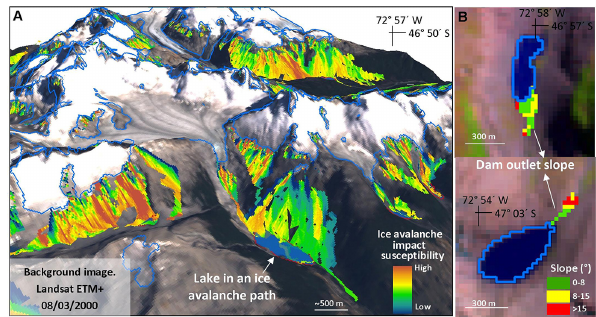
Figure 5. (a) Results of ice avalanche modelling and automatic clas- sification of glaciers. (b) Examples of lake outlet slope measure-